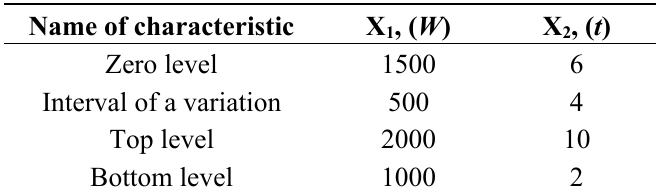
Table 1. The basic characteristics of the experiment.